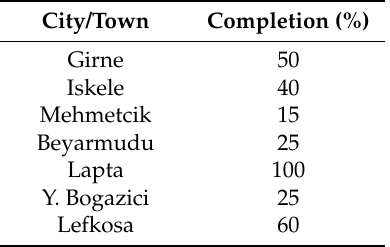
Table 5. The completion percentages of the sewage systems in towns in 2008